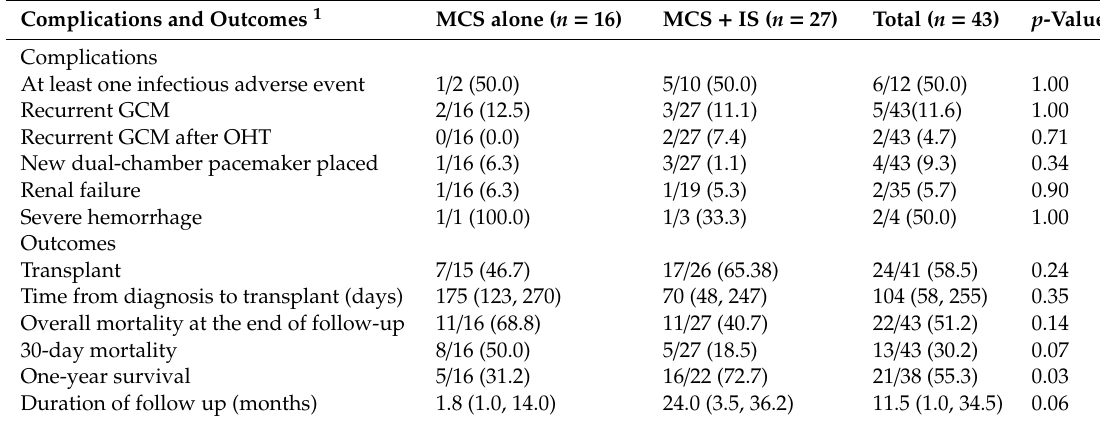
Table 4. Complications and outcomes of patients with GCM treated with MCS alone or in combination with